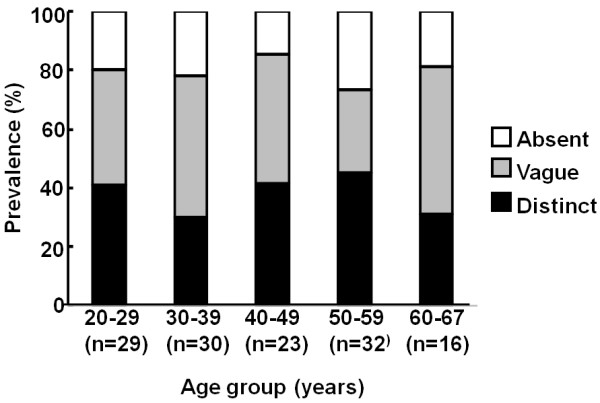
The prevalence of HPR in normal subjects, on axial T2-weighted images. The prevalence is given for each age group. “n” refers to the number of subjects in each age group. No significant difference in the prevalence of HPR was observed among the age groups.